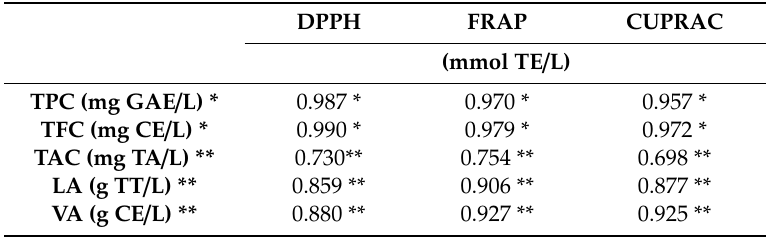
Table 3. Pearson’s correlation analysis between results of TPC, TFC, TAC, LA, VA, DPPH, FRAP and CUPRAC assays for all wine varieties.